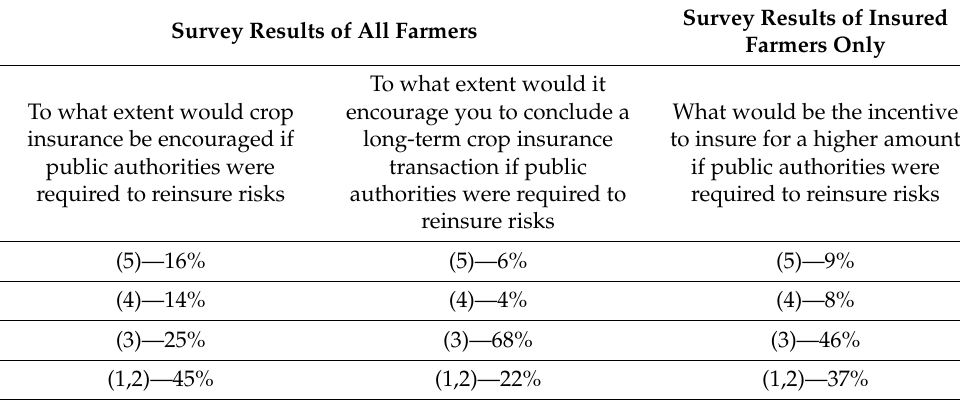
Table 3. Farmers’ views on the possibility of public authorities to reinsure insurance